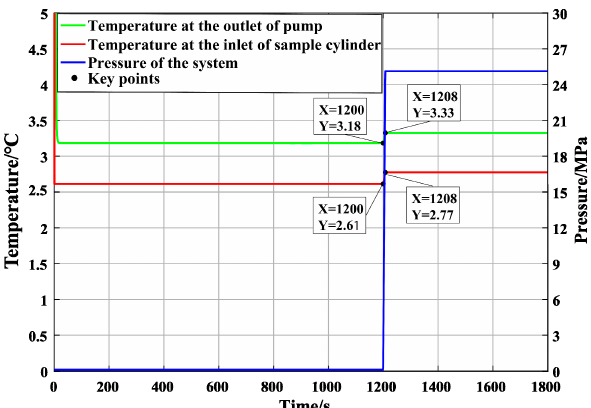
Figure 11. Simulation image of system temperature increase and pressure change.